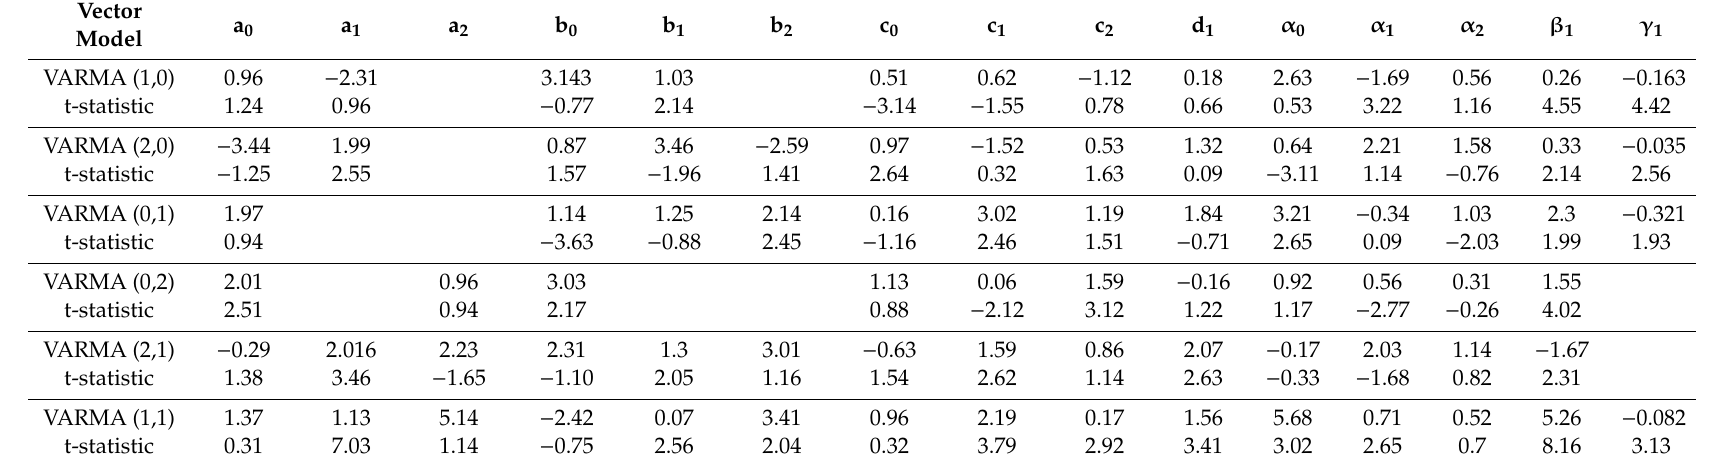
Table 5. Parameter estimation during the process when photochemical pollution factor VARMA (1,1) was paired with EGARCH